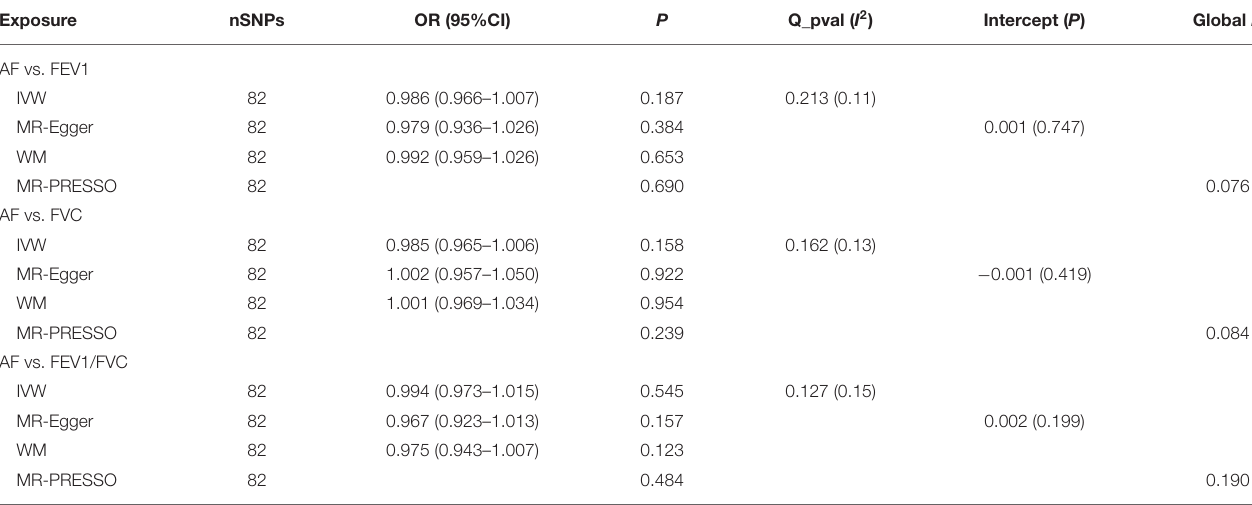
TABLE 4 | Reverse causal relations of AF with FEV1, FVC, and FEV1/FVC performed by uvMR. Exposure